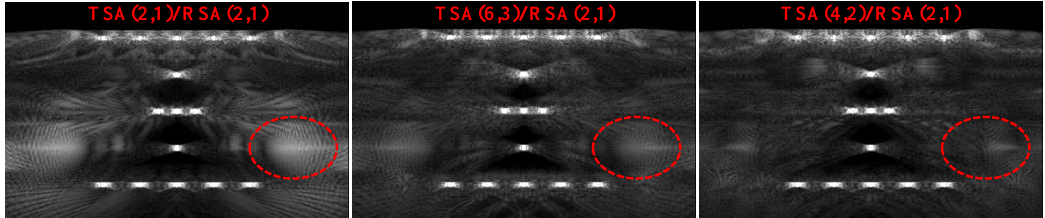
Figure 9. Point targets imaging comparison of SF two − way = 1/4. Table 3. Point-targets imaging quantitative comparison of SF two − way = 1/4.